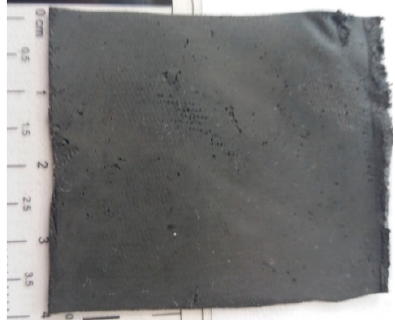
Figure 7. hMRE Figure 7. hMRE configuration.